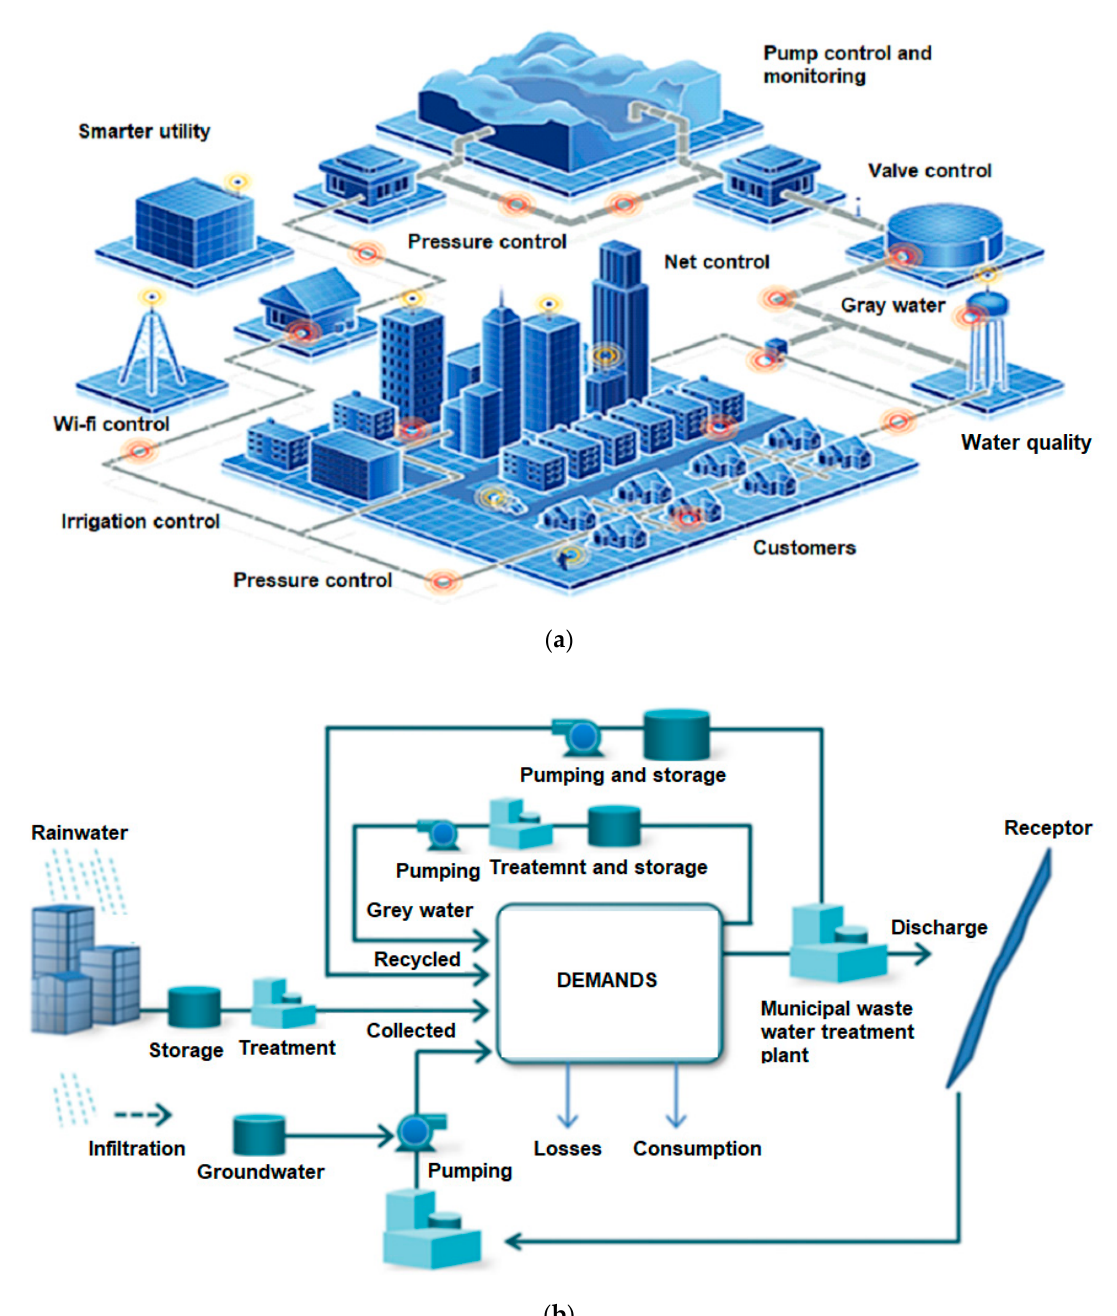
Figure 4. Holistic view of smart grids: integration of components in a smart water grid in urban environment ( a ); and water cycle process in a smart water grid ( b ).